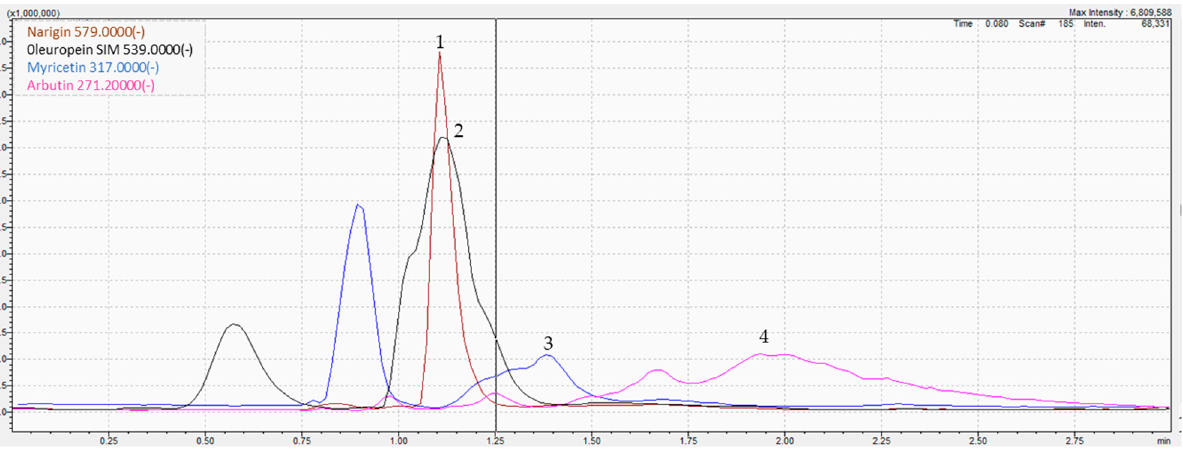
Figure 1. LC-MS/MS chromatogram of the hydro-ethanolic extract of P. sativum. ( 1 ) Naringin, ( 2 ) Oleuropein, ( 3 ) Myricetin, ( 4 ) Arbutin. Table 1. LC-MS/MS identification composition of P. sativum Hoffm. hydro-ethanolic extract.